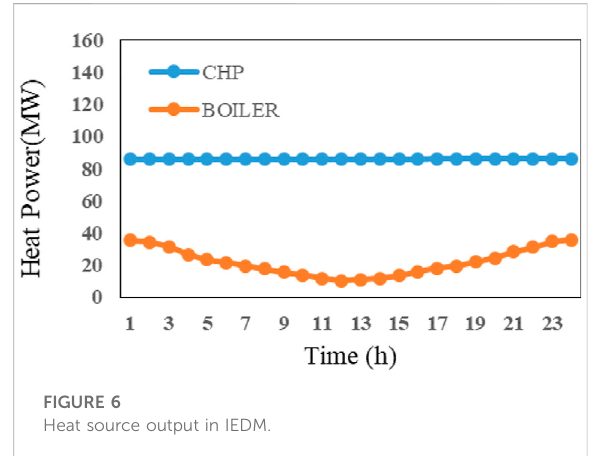
FIGURE 6 Heat source output in IEDM.